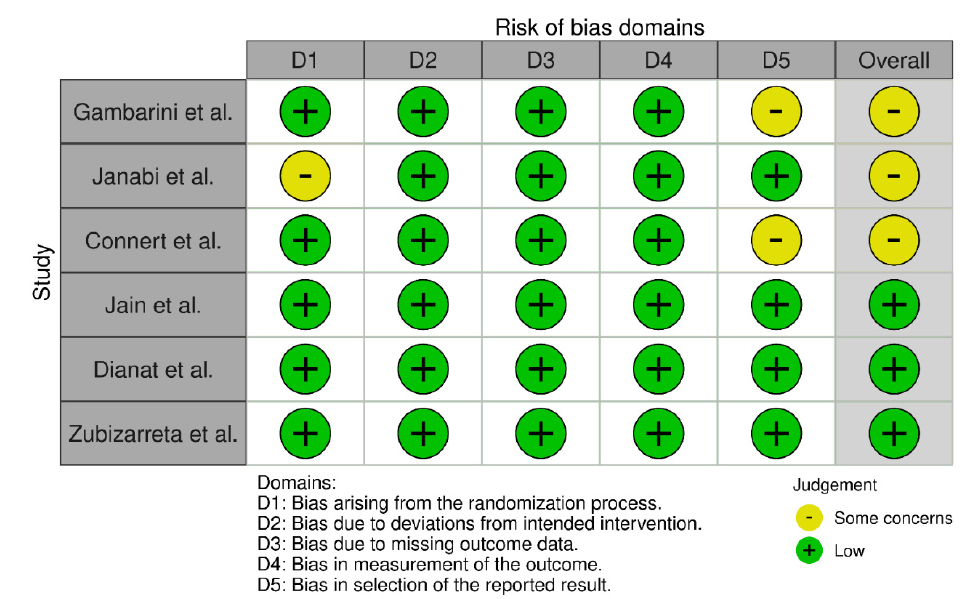
Figure 2. Risk of bias assessment using the modified RoB 2.0 tool. Gambarini et al. [15]; Janabi et al. [12]; Connert et al. [17]; Jain et al. [16]; Dianat et al. [13]; Zubi-zarreta et al., 2020 (Spain) [14].